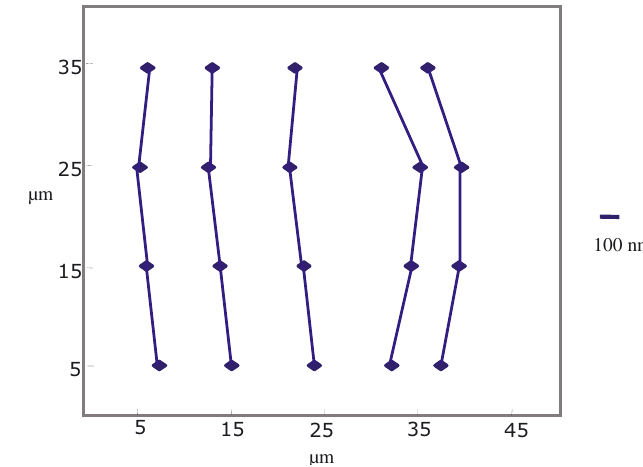
Fig. 4. The MARKET plot (matrix of 4 by 5) with blue light illumination. The scale bar at right measures the phase dif- ference of each subfield with the units of phase expressed in